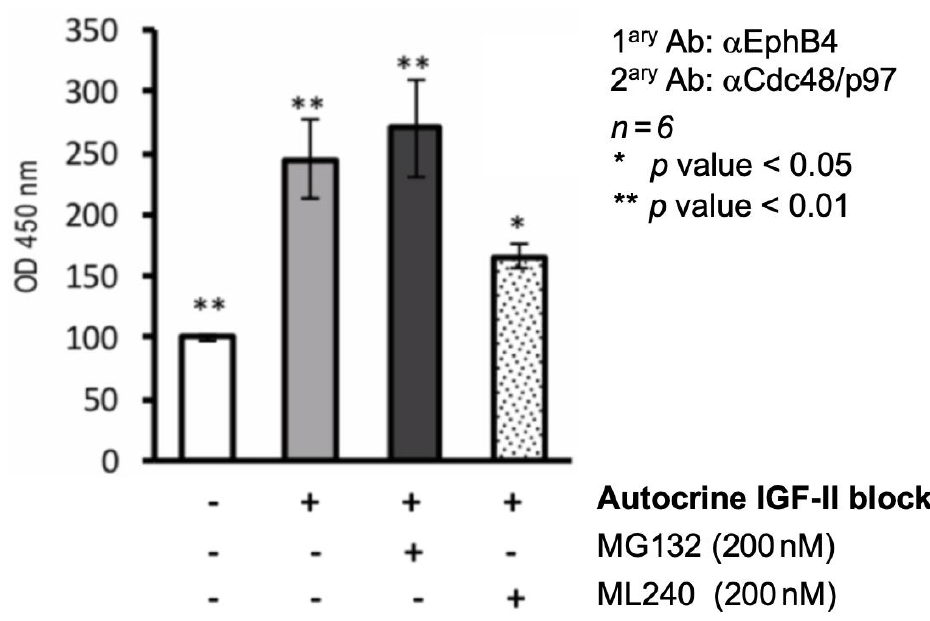
Figure 4. Coprecipitation of EphB4 requires a fully active cdc48/p97 ATPase/unfoldase. An ELISA was set up to capture native EphB4 from pre-treated MSTO211H lysates at a non-limiting target/capturing Ab rate, as described in the methods. This assay was used to detect the level of cdc48/p97 binding to native EphB4 in MSTO211H lysates upon selective inhibition of the proteasome pathway (MG132, 200 nM) or cdc48/p97 enzymatic activity (ML240, 200 nM). The graph shown here is the statistical representation (mean ± s.e.m) of three independent experiments performed in quadruplicate. Statistical analyses and p value were calculated using Student’s t -test with unequal variances.